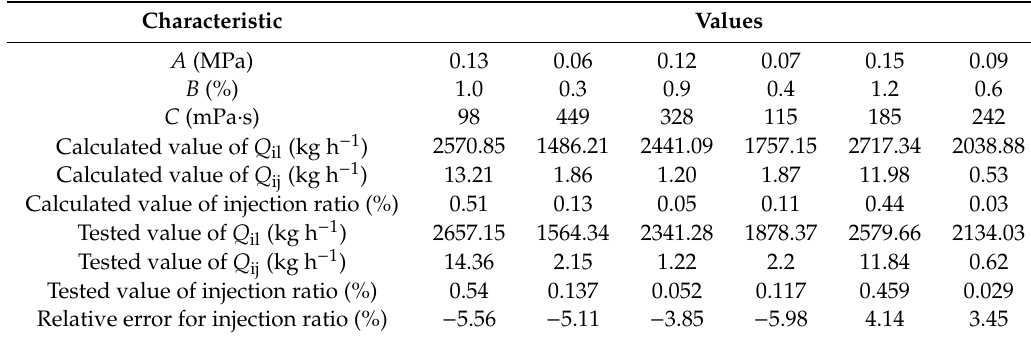
Table 7. Test results under di ff erent random